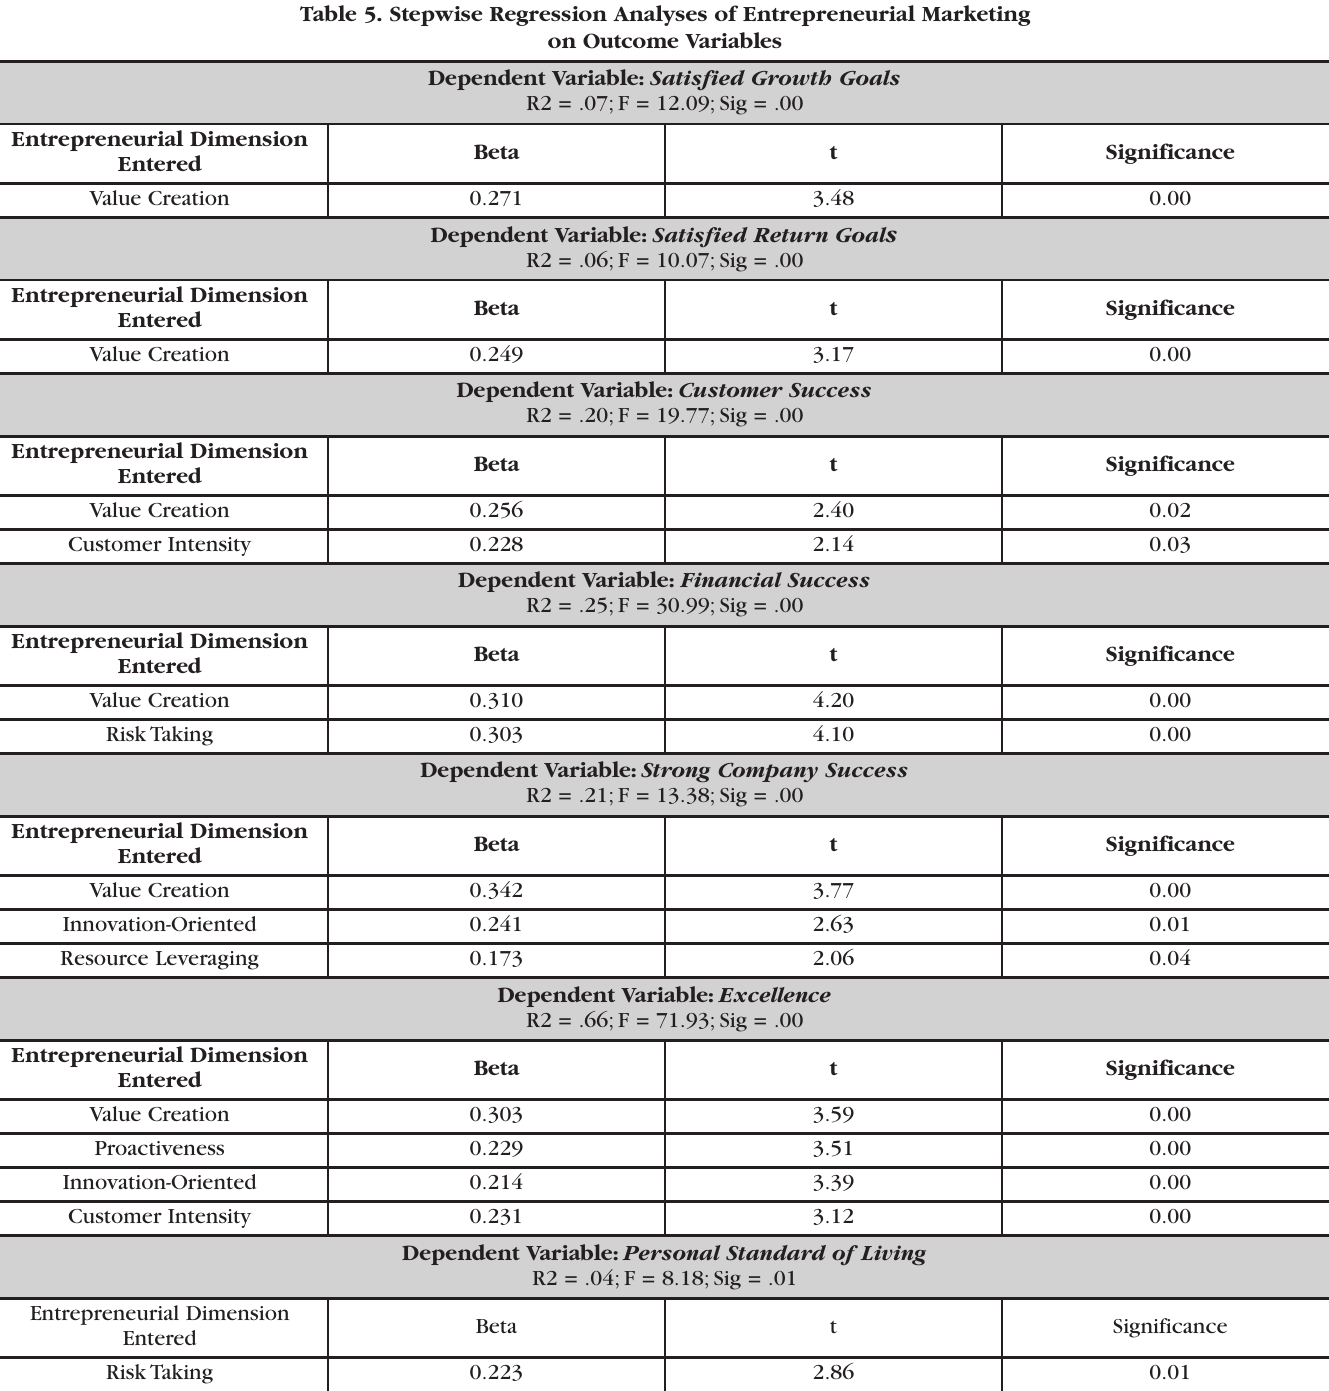
Table 5. Stepwise Regression Analyses of Entrepreneurial Marketing on Outcome